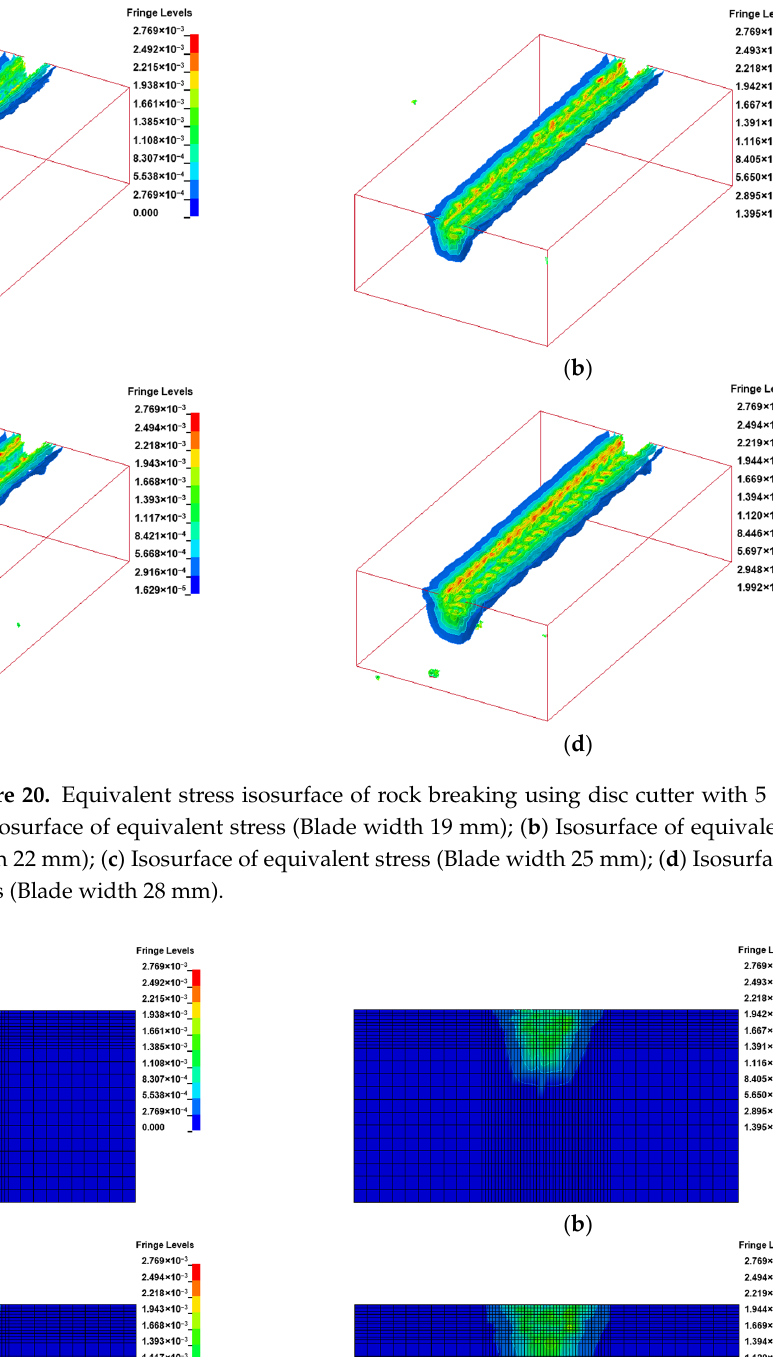
( b ) Rolling force; ( c ) Range and STD of normal force; ( d ) Range and STD of rolling force.